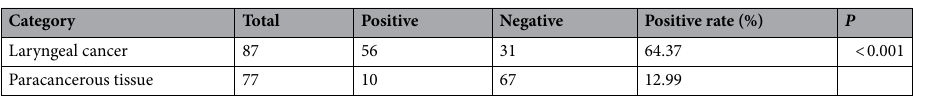
Category Total Positive Negative Positive rate (%) P Laryngeal cancer 87 56 64.37 < 0.001 Paracancerous Table 1. Aldosterone reductase family 1 member B10 expression in laryngeal cancer and adjacent tissues.